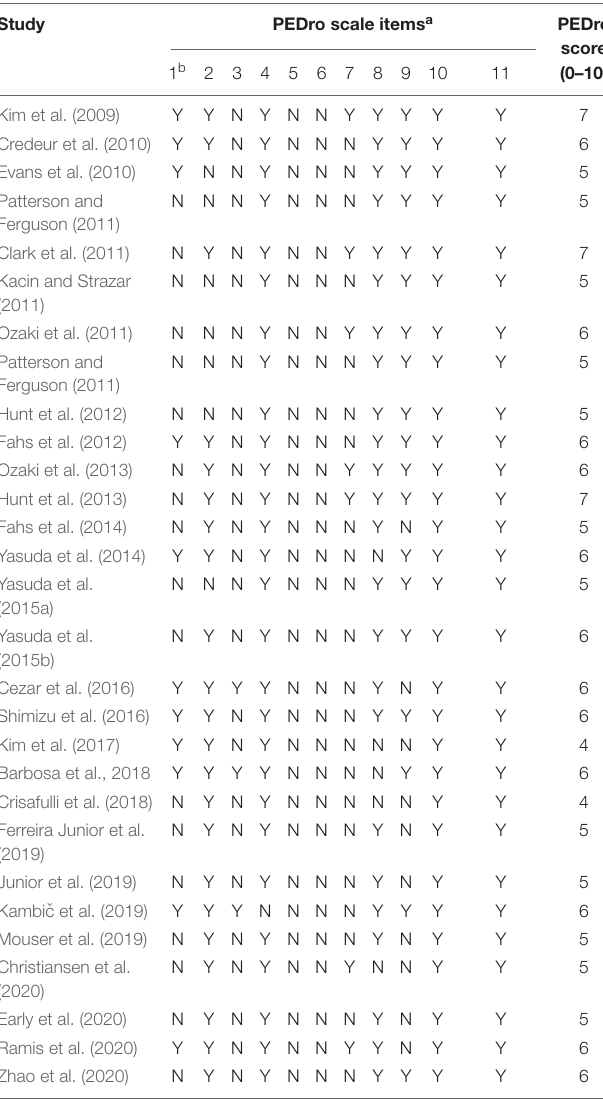
TABLE 3 | Methodological quality of eligible studies ( n =